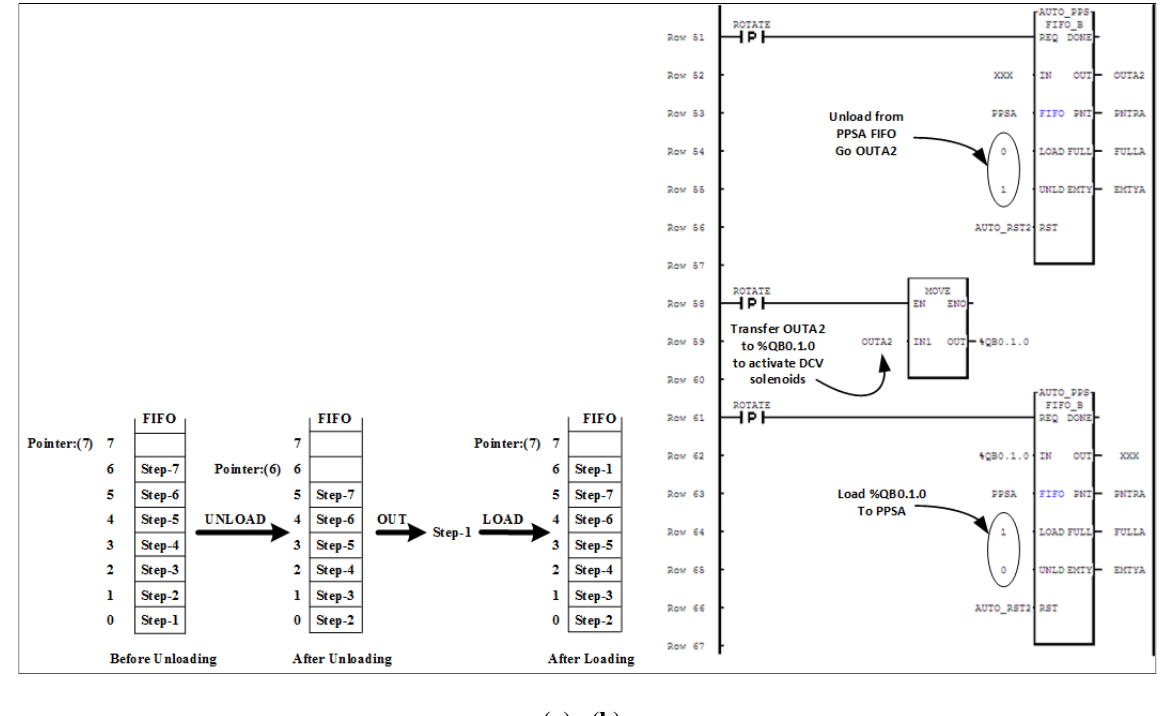
Fig. 6. FIFO stack Function Block Operation at Auto Mode.